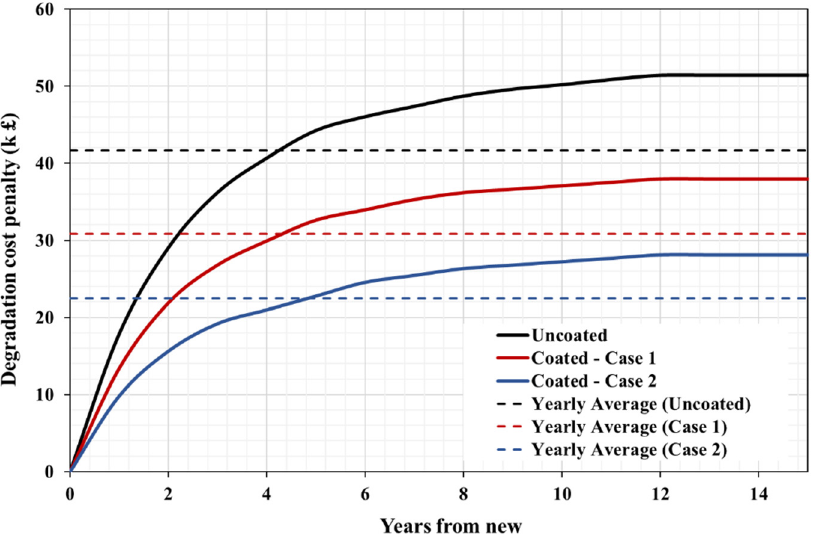
Figure 4. Fuel penalty degradation (yearly variation and average over the life of the engine).